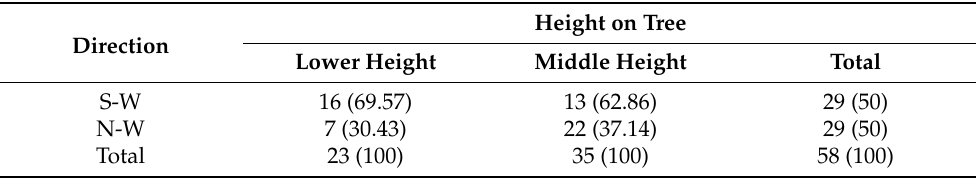
Table 7. Crosstable of frequency (in brackets: %) in stem-pith eccentricity at 2–4 m distance zone for the 2.5 m variant ( χ 2 = 5.84, df = 1, p =